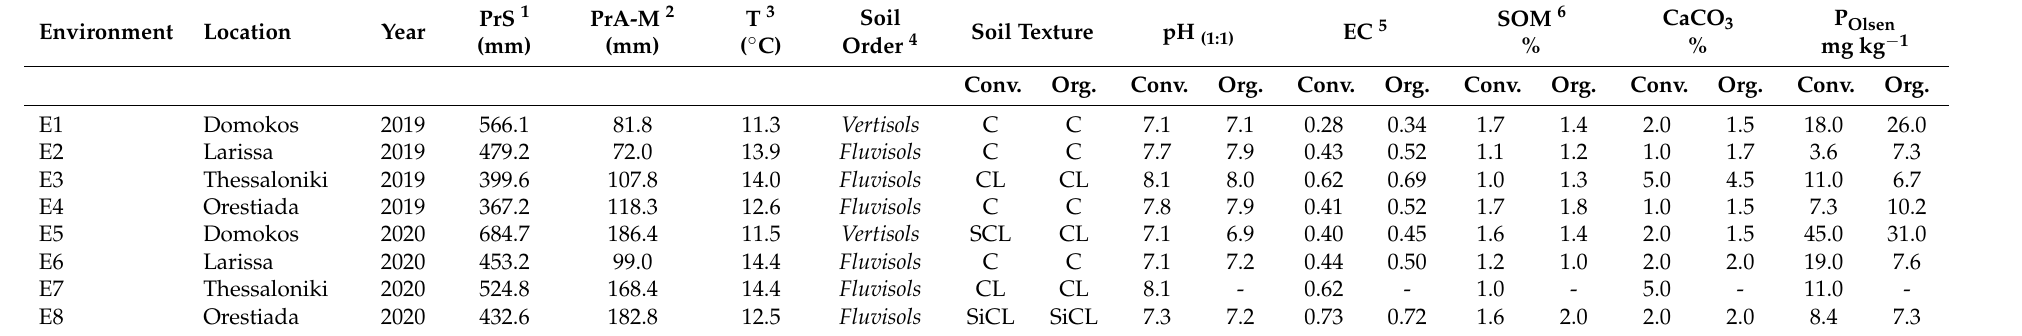
Table 4. Meteorological data, soil order and basic soil parameters of the 8 Environments (Location × year) over 2019 and 2020 growing seasons. Soil parameters refer to conventional (Conv.) and organic (Org.) farming conditions at 0–30 cm